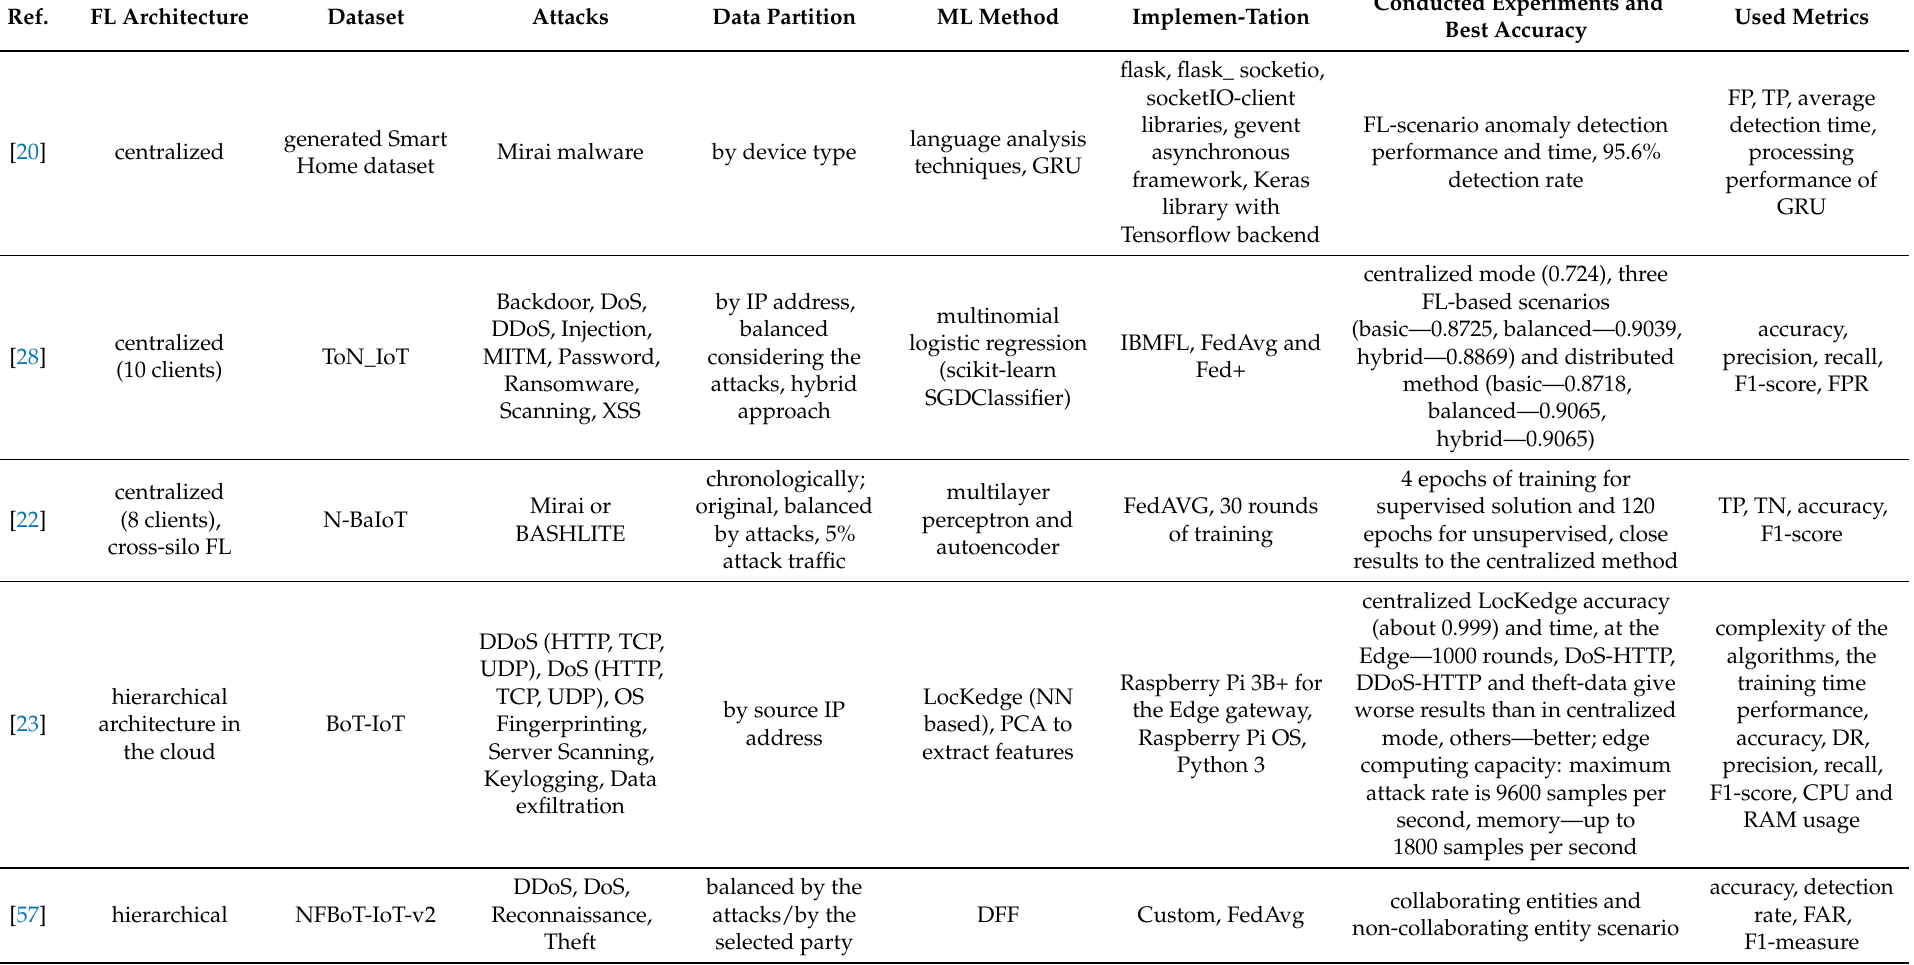
Table 1. Comparison of the federated learning